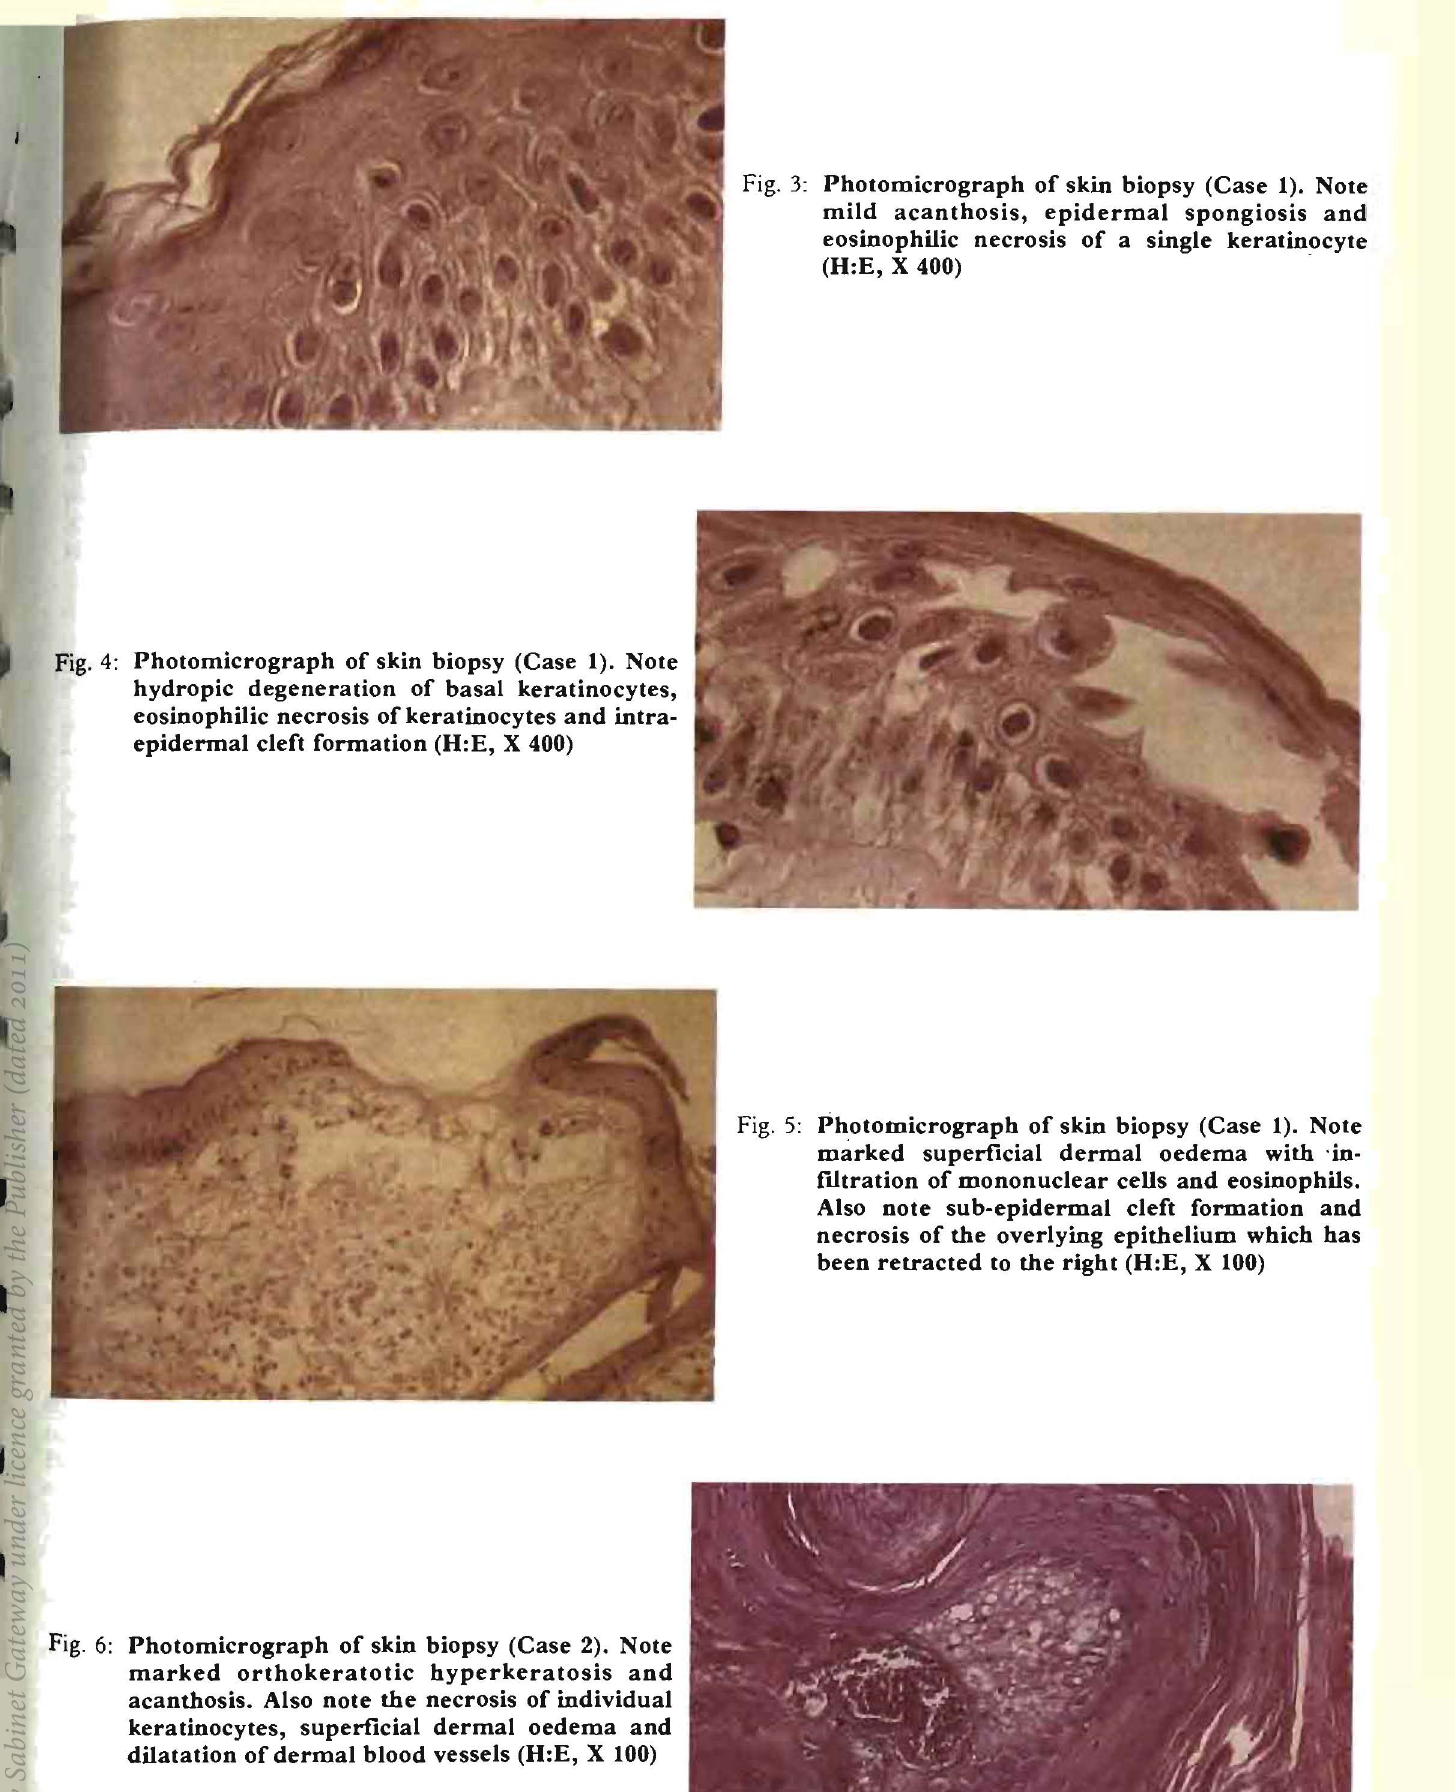
0038-2809 JI SA/T. vet.Ass. (J 991) 62(3): 133-136